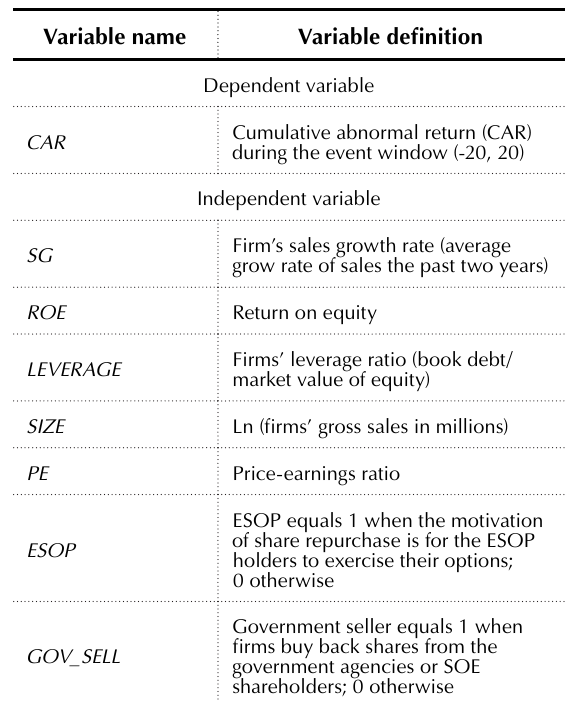
Table 1. Variable definitions (for equation